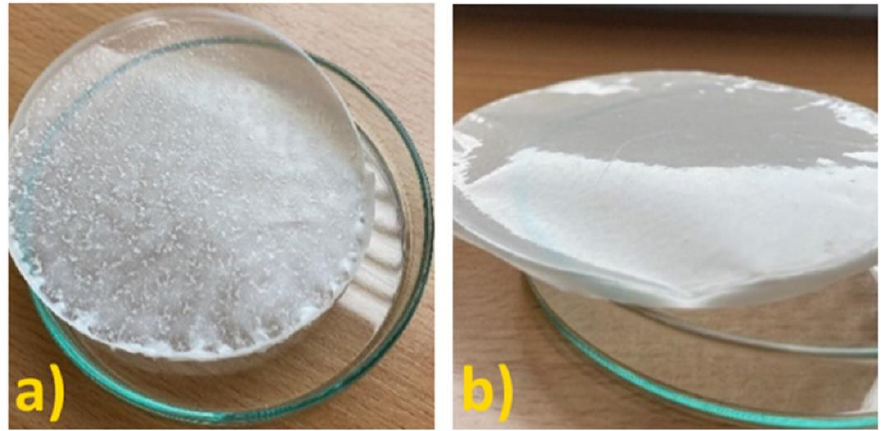
Figure 3. Polycaprolactone-hydroxyapatite (PCL-HA) 10 film after drying in the oven: ( a ) upper side; ( b ) lower side.